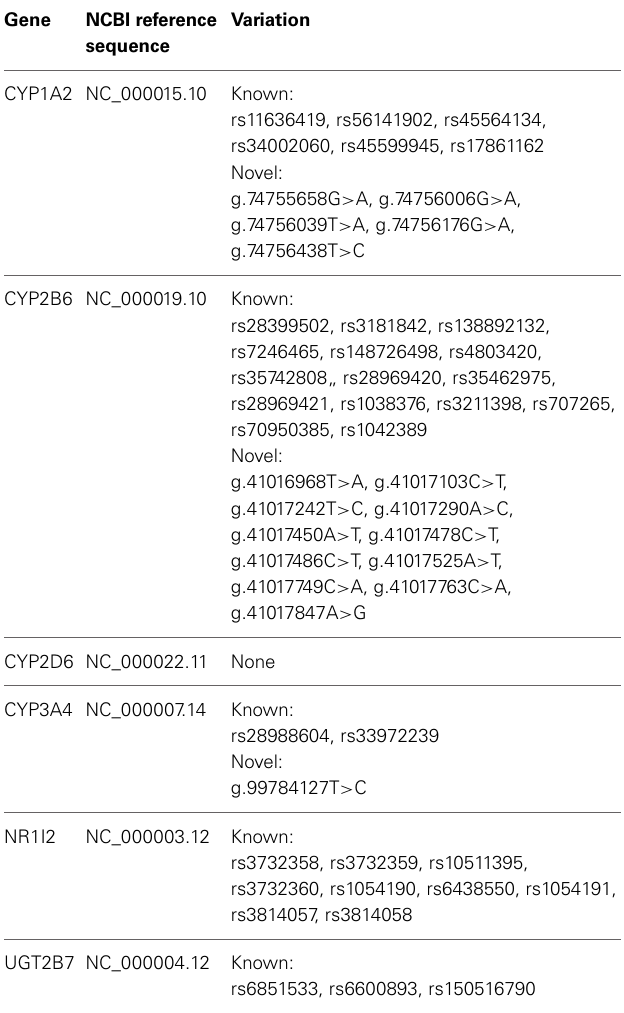
Table 3 | Genetic variation identified in the 3 (cid:2) -UTR of CYP1A2, CYP2B6, CYP2D6, CYP3A4, NR1I2, and UGT2B7 after sequencing of 30 black South